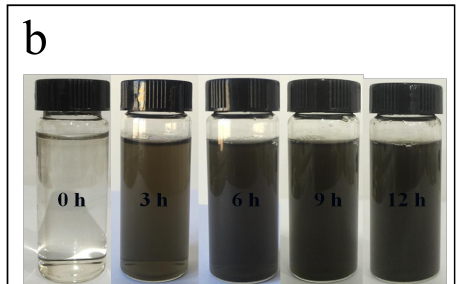
Figure 5. ( a ) The weight gain and the PDA particle size of the fabric with the treatment time of dopamine; ( b ) the color change of the dopamine solution.